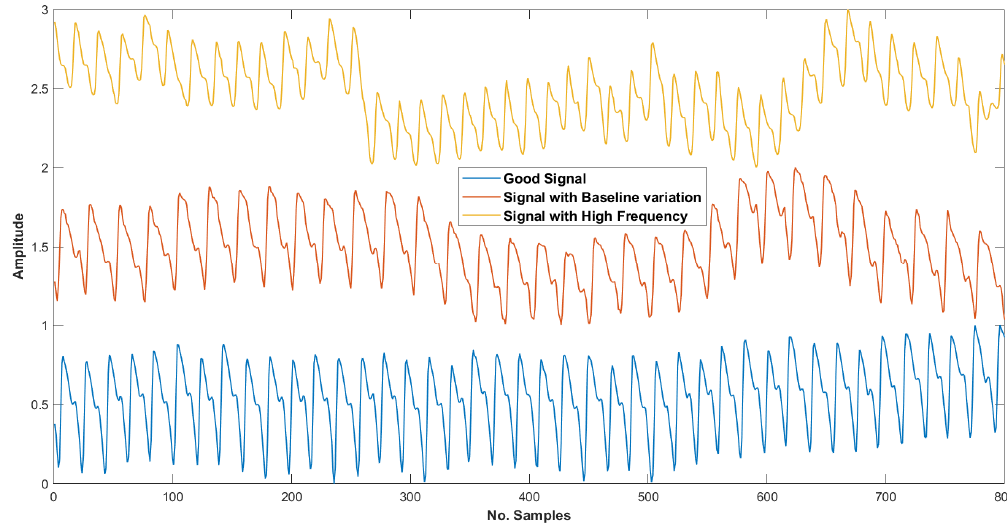
Figure 4. Normalized PPG signals with different qualities—a signal with both baseline variations and high-frequency noises ( top ), a signal with baseline variations ( middle ), and a good one with no high-frequency noise and little baseline variation ( bottom ).